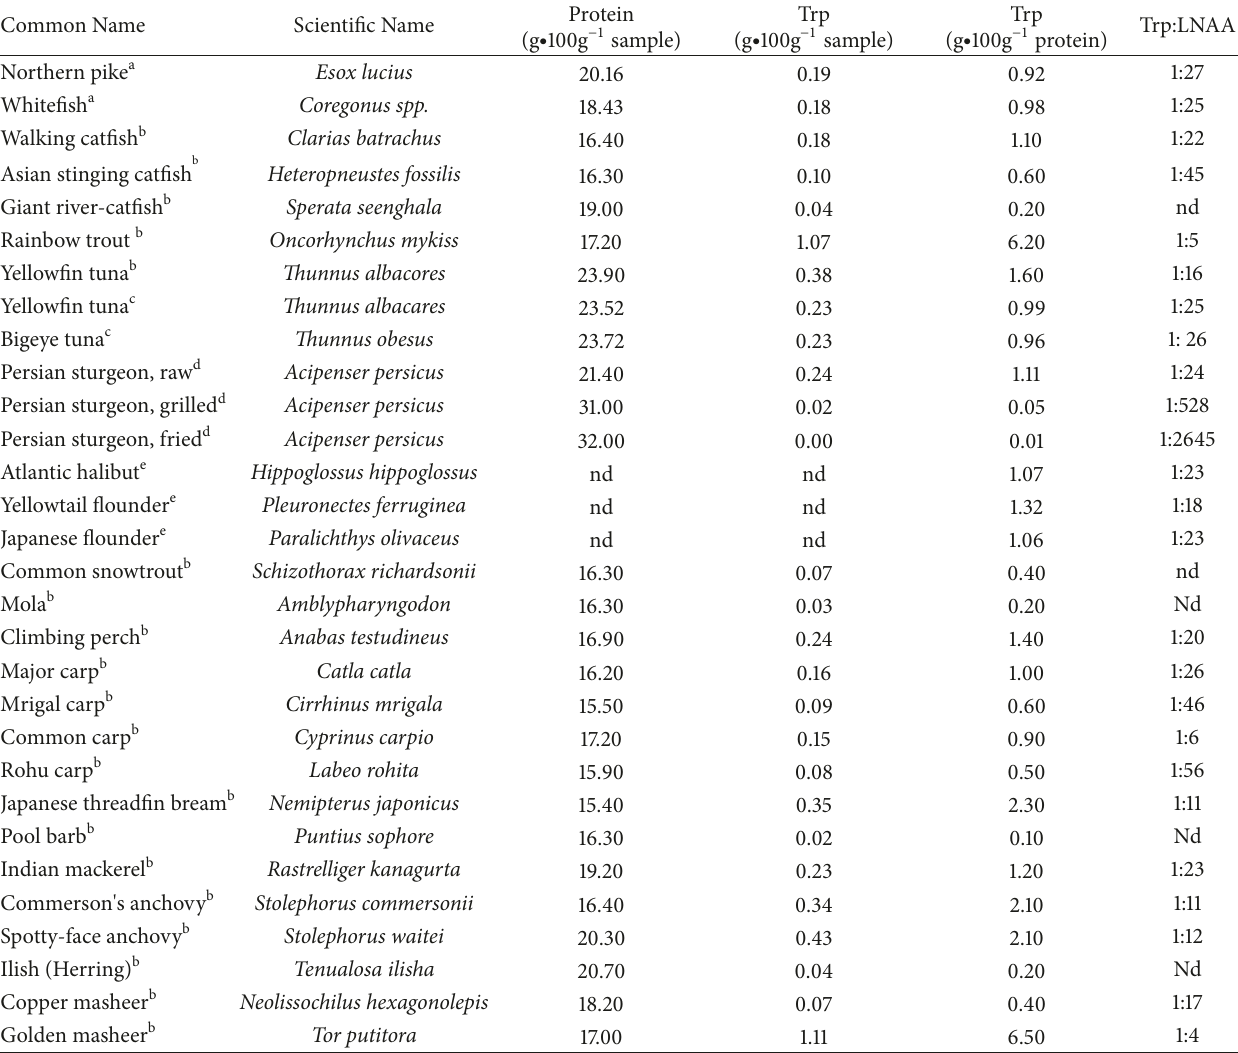
Table 12: Tryptophan Content in Fish of Present Study and Previous